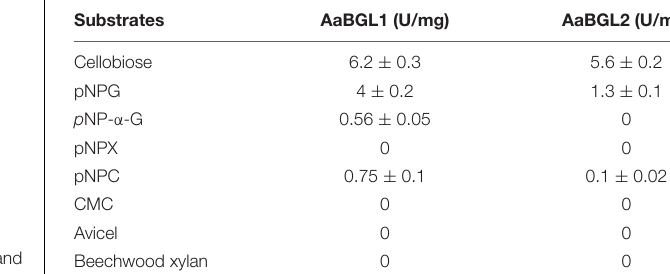
FIGURE 6 | Effect of glucose concentration on recombinant (A) AaBGL1 and (B) AaBGL2.